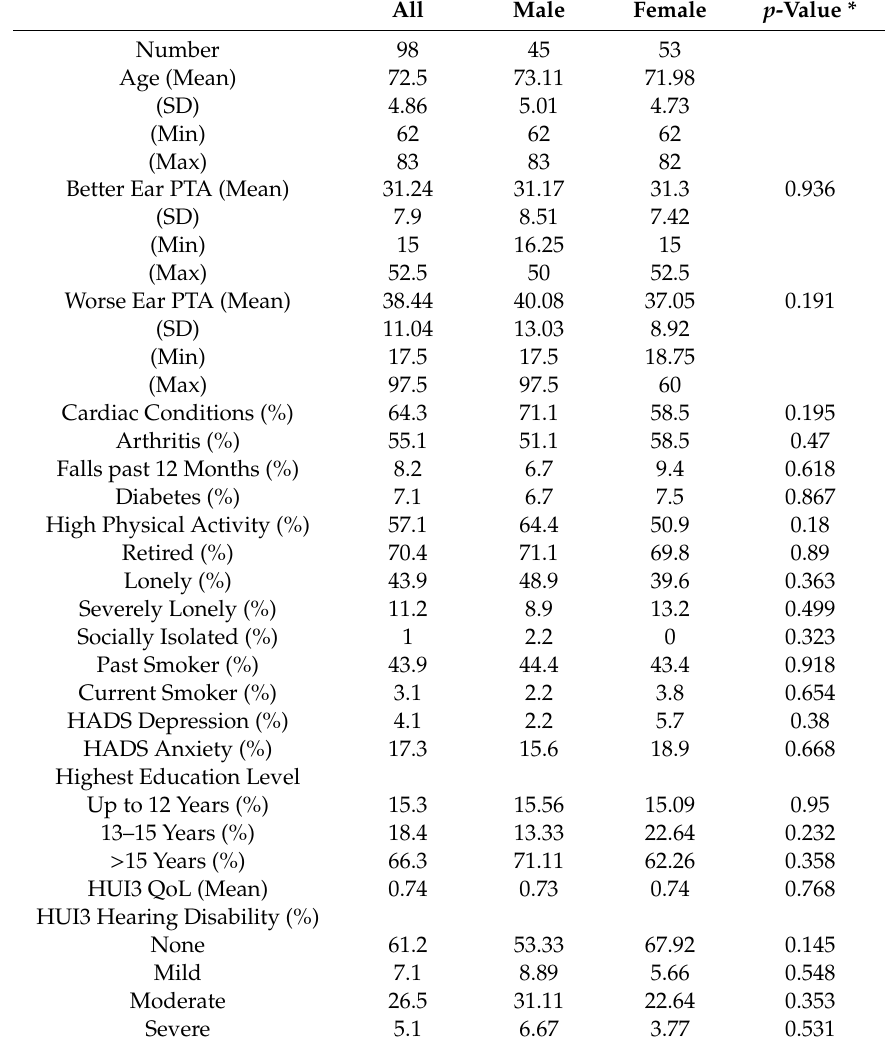
Table 1. Demographic and audiometric characteristics of participants overall and by sex at baseline ( n = 98). All Male Female p -Value